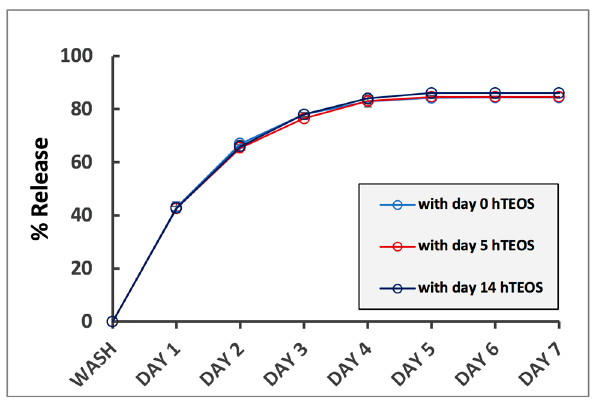
Figure 4. Effect of hTEOS age on the drug release rates from TXG. Error bars are hidden in the plot symbols when not visible.